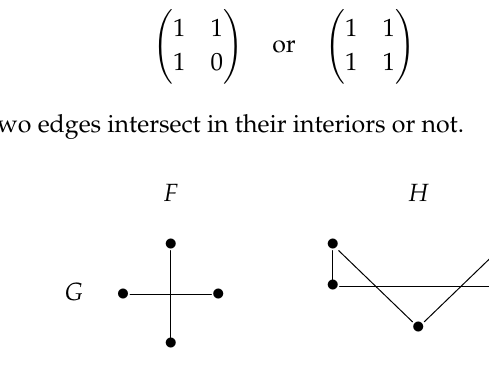
Figure 2. Two topologically inconsistent